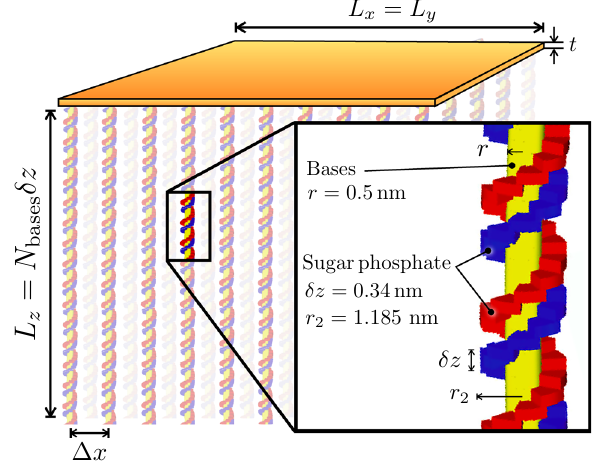
Fig. 2 Closeup of DNA strand model setup constructed in TOPAS and which is used to count incoming particle interactions with Geant4. The model shown here is a simplification of a double stranded DNA molecule. The central yellow cylinder with radius 0.5 nm represents the sequenceofbasepairs,whichforsimplicityweassumeareallcomposed of adenine. The winding sugar phosphate backbones (red/blue) each are made of cylindrical segments with heights in the z -direction of 0.34 nm. Since we assume a 2000 base-long DNA strand, the total height of the detector L z = 680 nm. Though this is not in any way a biologically accurate model of a DNA strand, it does still reflect the basic geometry and broad composition, which is what is important for our